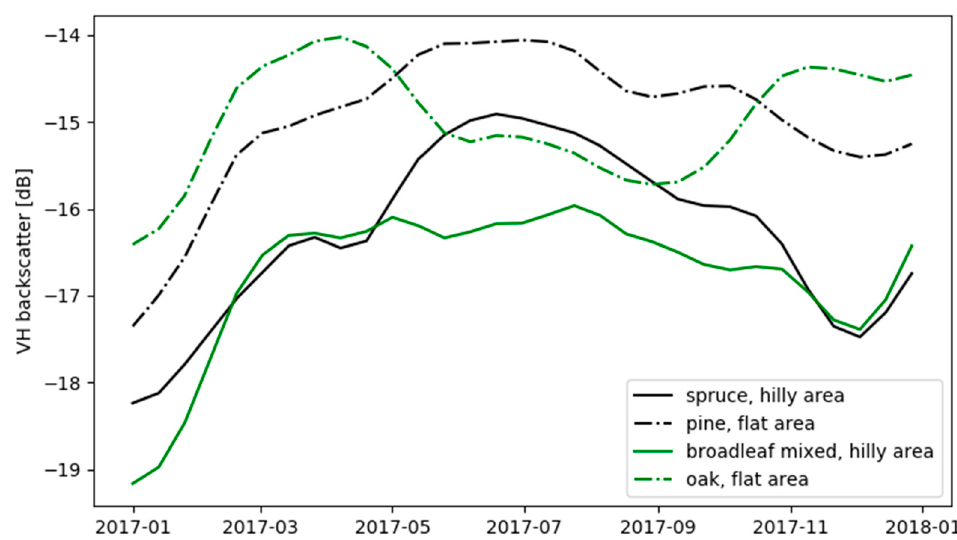
Figure 3. Overview of the regions used for the Sentinel-1 forest maps computation (black lines) and the locations of their respective signature prototypes (grey points) across Europe. Red lines indicate the Equi7 grid tiling.